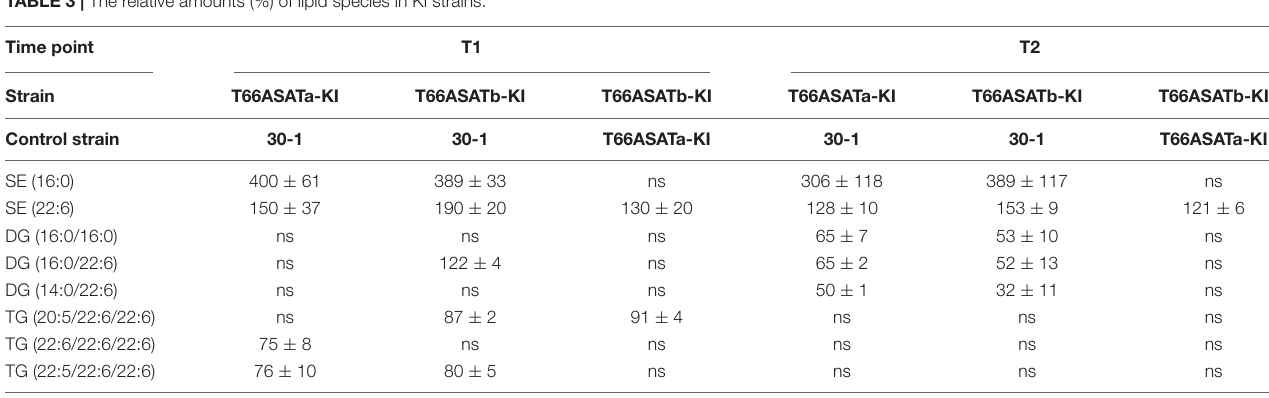
Control strains are set to 100%. All values are expressed as mean ± the standard deviation of the triplicates originating from three independent cultures. ns: the amount of the lipid species was not significantly different for the two strains. TABLE 3 | The relative amounts (%) of lipid species in KI strains.